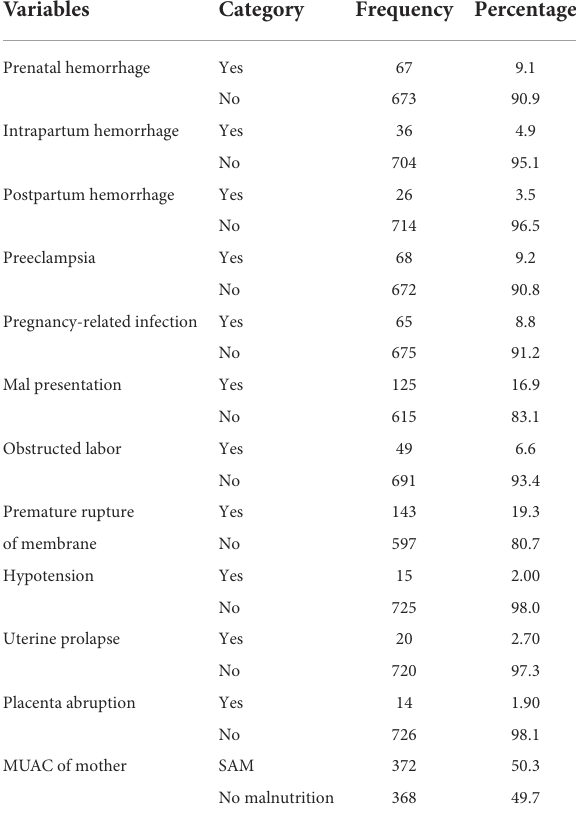
TABLE 4 Child health-related characteristics among neonates delivered in North Shewa Zone Public Health Hospital, Oromia region, Central Ethiopia,